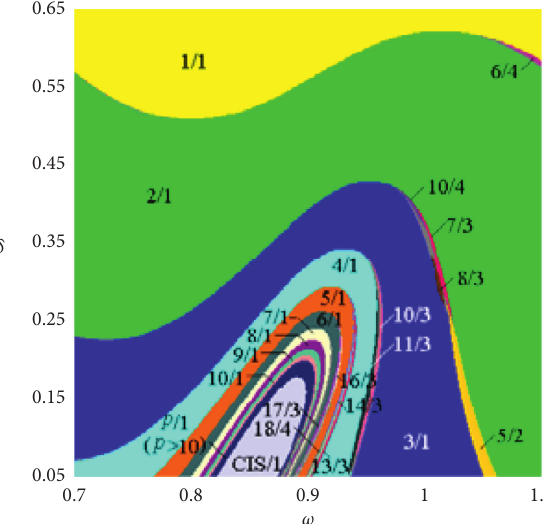
Figure 23: Periodic motions on the ( ω , δ ) -parameter plane associated with each constraint when ζ � 0.2. (a) Constraint A A 12 ; (c) constraint A 2 .